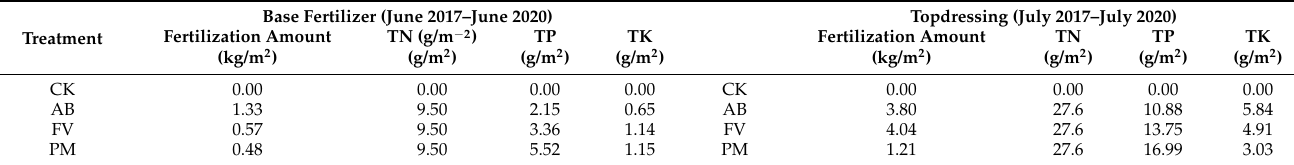
Table 3. Quantities of base fertilizer and topdressing to the rice of the field